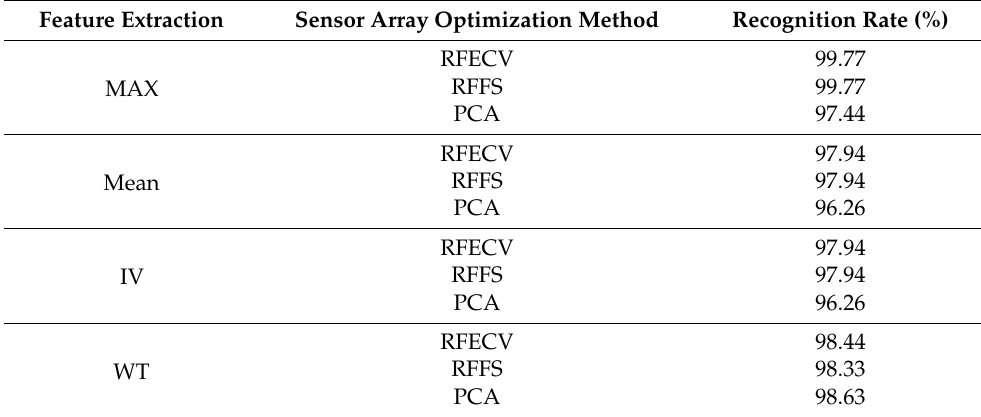
Table 5. The classification recognition rate based on RF after using different methods (limited the number of sensors in the sensor array to